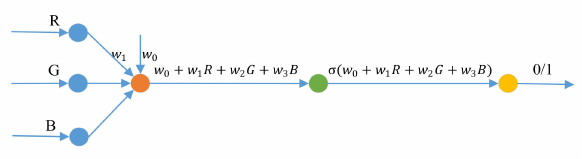
Figure 4. Schematic diagram of ternary logistic